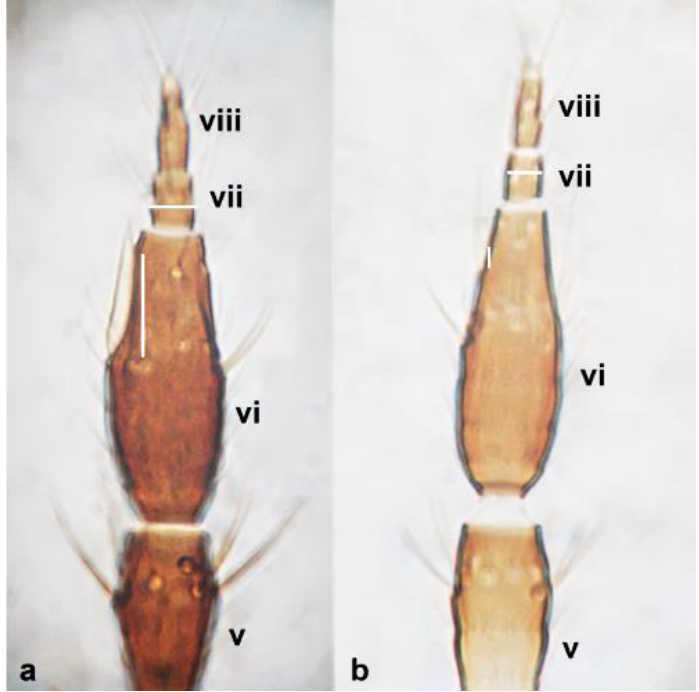
Figure 30. Sensorium on antennal segment VI: ( a ) with base of sensorium longer than width of segment VII; ( b ) with base of sensorium shorter than width of segment VII.